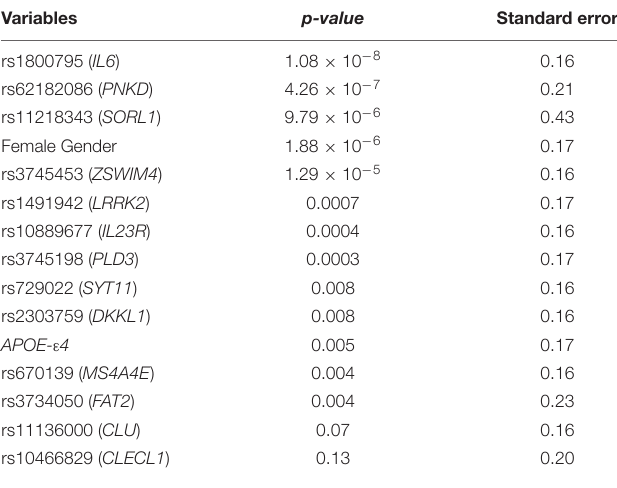
TABLE 4 | Regression analysis model for evaluating the predictiveness of the variants associated with sporadic